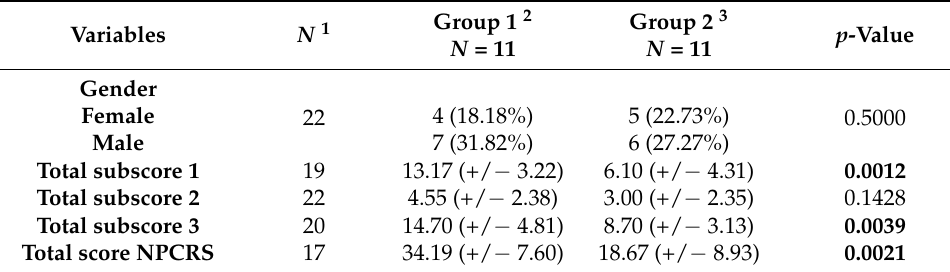
Table 5. Subscores and total Nijmegen score in patients with one variant affecting dimerization domain together with one non-functioning allele and patients with one non-functioning